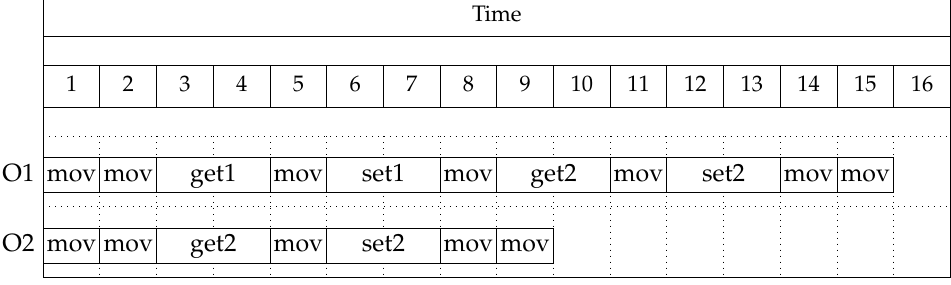
Figure 13. A schedule of actions for a scenario created with a walk of the length of 18